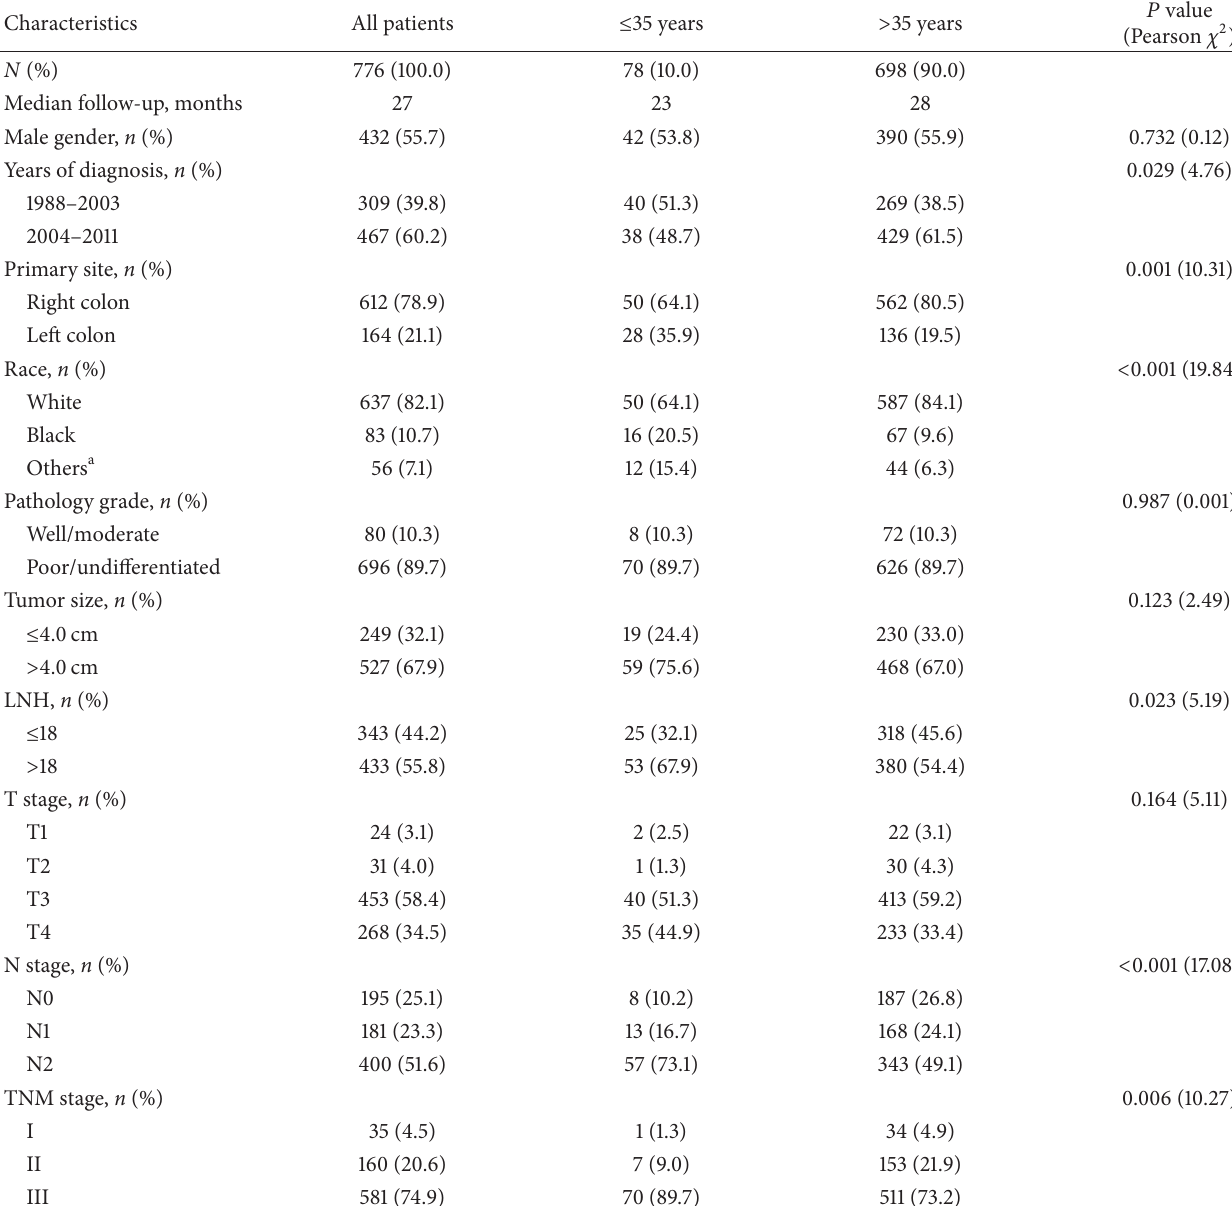
Table 1: Demographic and baseline characteristics of patients with nonmetastatic signet-ring cell carcinoma of the colon from the SEER database and stratification by age at